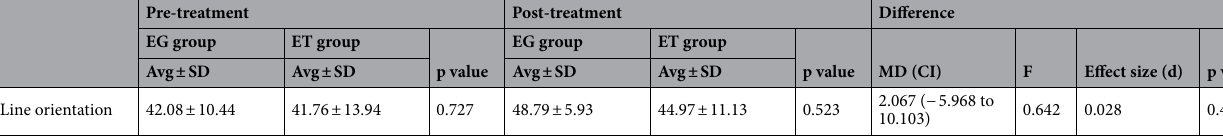
Table 4. Between group findings. Avg average, SD standard deviation, UPDRS Unified Parkinson’s Disease Rating Scale, BBT Berg Balance Test, TUG Timed-up and Go Test, 6MWT 6 min walk test, ABCS Activities- specific Balance Confidence Scale, MMSE Mini-Mental State Examination, MoCA Montreal Cognitive Assessment, GDS Geriatric Depression Scale, PDQ-39 Parkinson’s Disease Questionnaire, TD Time Difference,